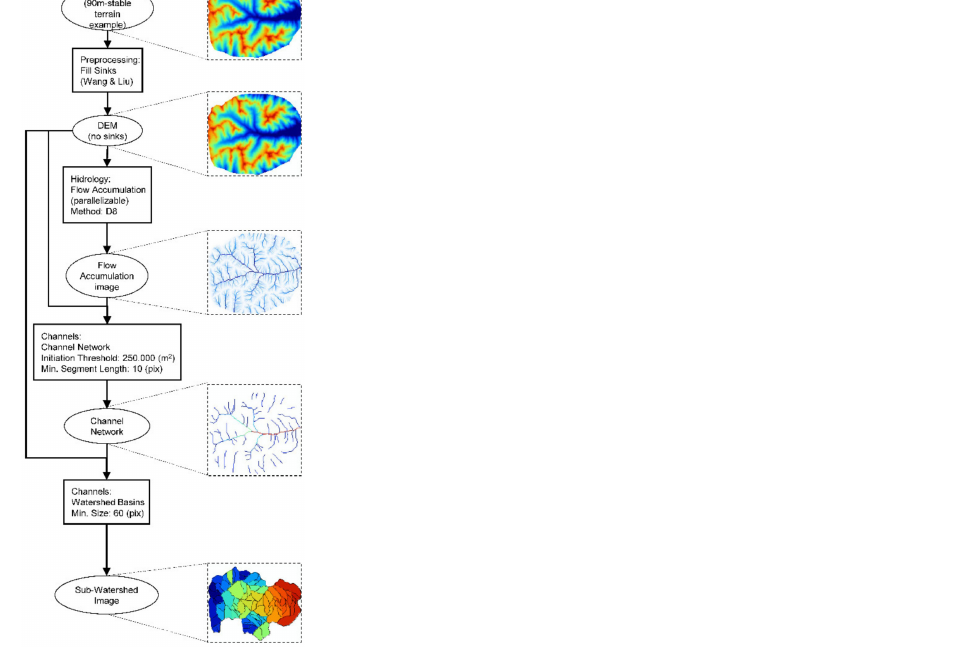
Figure 4. Scheme and settings applied to subwatershed delineation. The images on the right side show a step-by-step example from Magellan